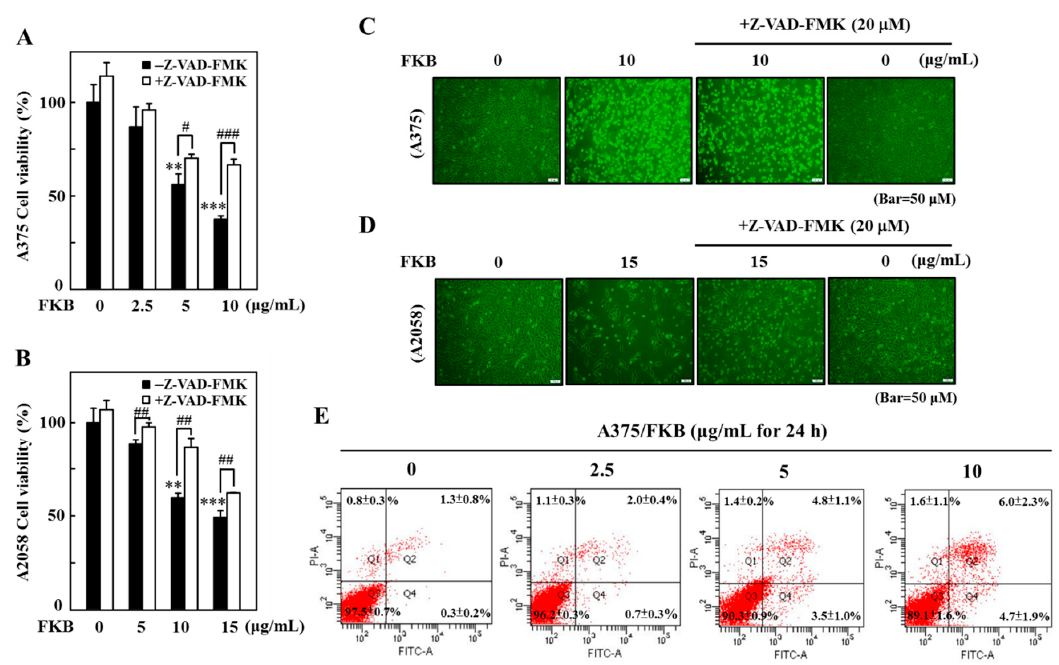
Figure 3. FKB induced apoptotic cell death of A375 and A2058 cells. Cells were pretreated with pan-